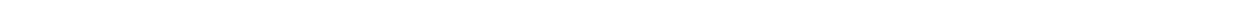
Figure 4 | Calcium at filopodia tips regulates filopodia stability. ( a ) MDA-MB-231 cells transiently expressing the calcium probe (pGP-CMV-GCaMP6s) and MYO10-mCherry were plated on FN and imaged live using a TIRF microscope (1 picture every 5s; scale bar, 20 m m). The intensity of the calcium probe at MYO10-positive filopodia tips was measured and compared between transient ( o 1min lifetime) and stable filopodia ( 4 1min lifetime) ( n ¼ 276 filopodia, three biological repeats, *** P value o 1.8 (cid:3) 10 (cid:2) 9 ). ( b ) MDA-MB-231 cells transiently expressing GFP and MYO10-mCherry were plated on FN and imaged live using a TIRF microscope. The intensity of GFP at MYO10-positive filopodia tips was measured and compared between transient and stable filopodia ( n ¼ 293 filopodia, three biological repeats). ( c – e ) MDA-MB-231 cells transiently expressing the calcium probe (pGP-CMV-GCaMP6s) and MYO10-mCherry were plated on FN, treated with DMSO, felodipine or amlodipine besylate (10 m M) and imaged live using a TIRF microscope (1 picture every 5s; scale bar, 20 m m). Representative images are shown ( c ). For each condition, MYO10-positive particles were automatically tracked and MYO10 spot lifetime (calculated as a percentage of the total number of filopodia generated per cell) ( d ) and average MYO10 spot velocity ( e ) were plotted (see method for details; three biological repeats, n 4 5,600 particles tracked in more than 16 cells, * P value ¼ 0.015, *** P value o 2.98 (cid:3) 10 (cid:2) 5 ). ( f , g ) MDA-MB-231 cells transiently expressing lifeact-GFP were plated on FN, treated with DMSO, felodipine or amlodipine besylate (10 m M), and imaged live on a TIRF microscope. Movies were segmented and endogenous filopodia automatically identified using CellGeo 51 (See method for details). Average filopodia number per frame and per cell ( f ) and average filopodia lifetimes are displayed ( g ) ( n 4 16 cells, two biological repeats; * P value ¼ 0.035, *** P value o 5.6 (cid:3) 10 (cid:2) 5 ). P values were calculated using Student’s t -test (unpaired, two-tailed, unequal variance). All error bars represent